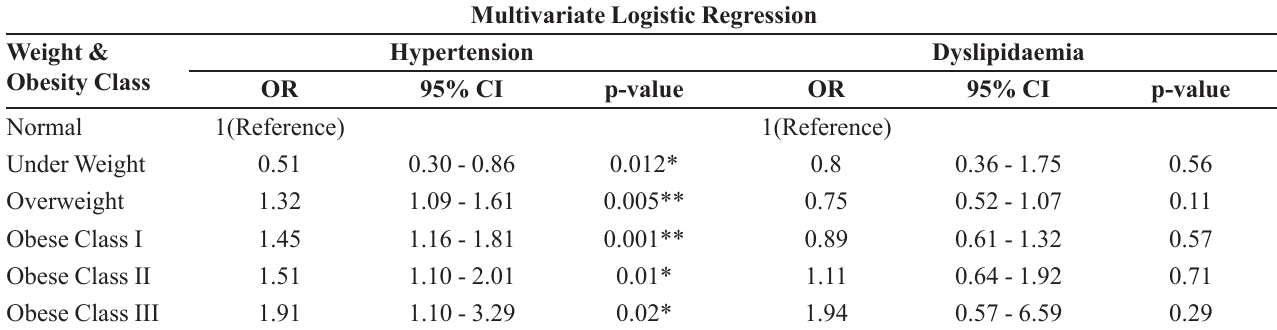
TABLE V - Multivariate logistic regression – Odds of hypertension and dyslipidaemia prevalence with increasing obesity class Multivariate Logistic